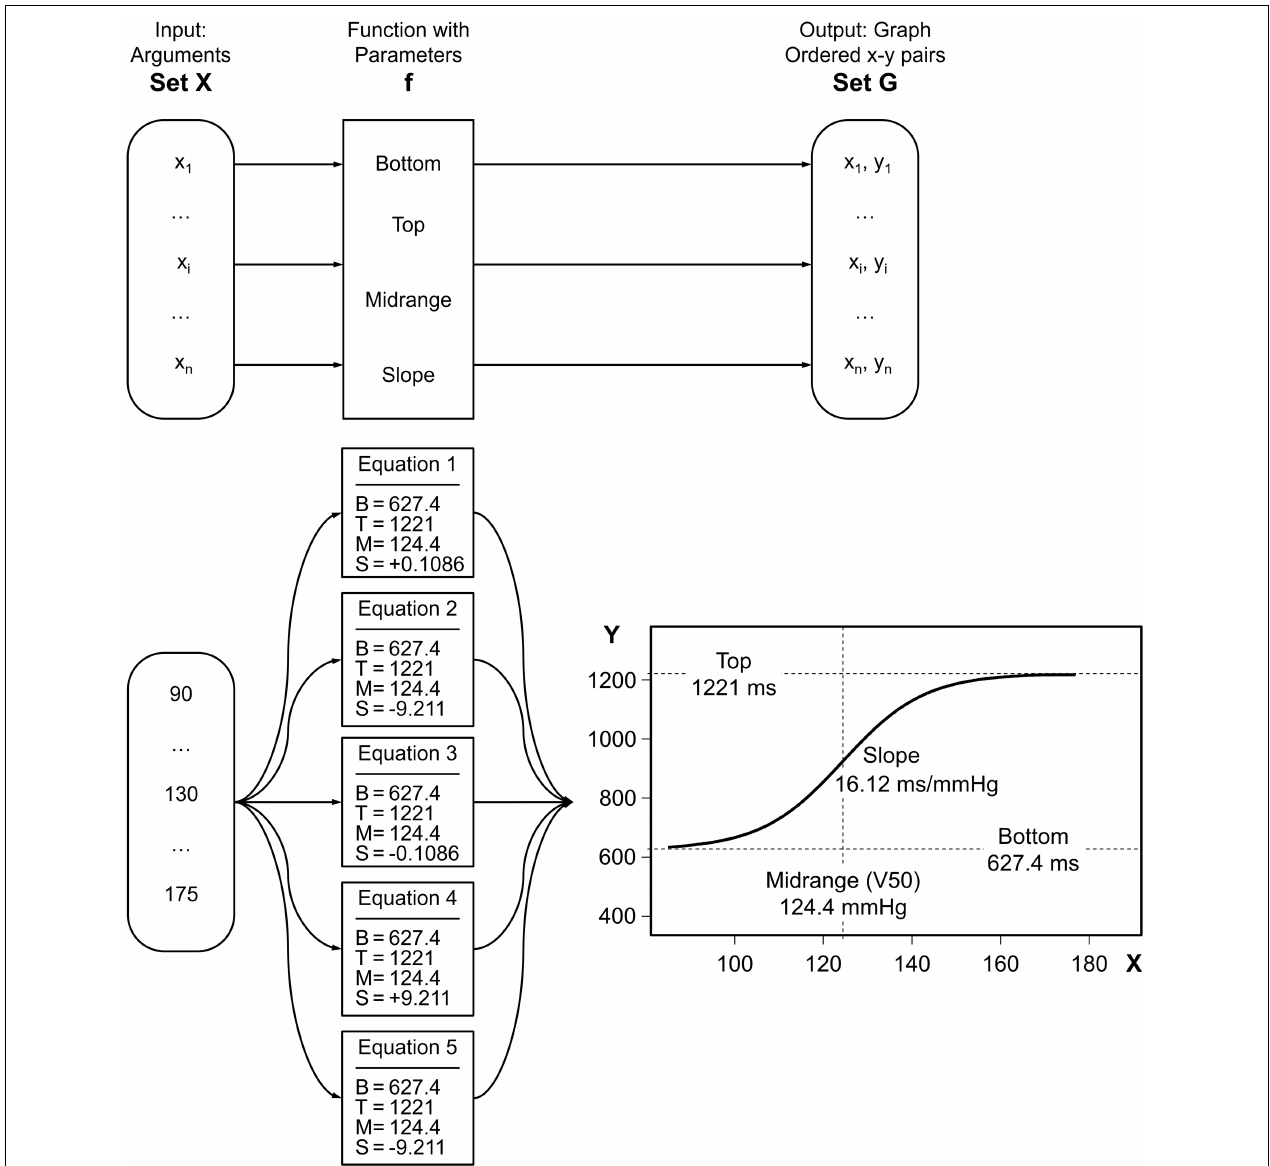
FIGURE 2 | Discrepancy between the equations’ Slope parameters and their graphs’ slopes. The five function boxes in the middle column of the figure implement the versions of the 4-parameter logistic equations in Table 1 . The parameters [B]ottom, [T]op, and [M]idrange are identically set for all functions while [S]lope settings differ. However, the functions’ graphs are identical. In other words, the curves representing them are exactly superposed (bottom right). Their identical Slopes at the inflection point at Midrange are 16.12. Hence, there is a discrepancy between [S]lope parameter settings in the functions (middle column) and the functions’ graphs (on the